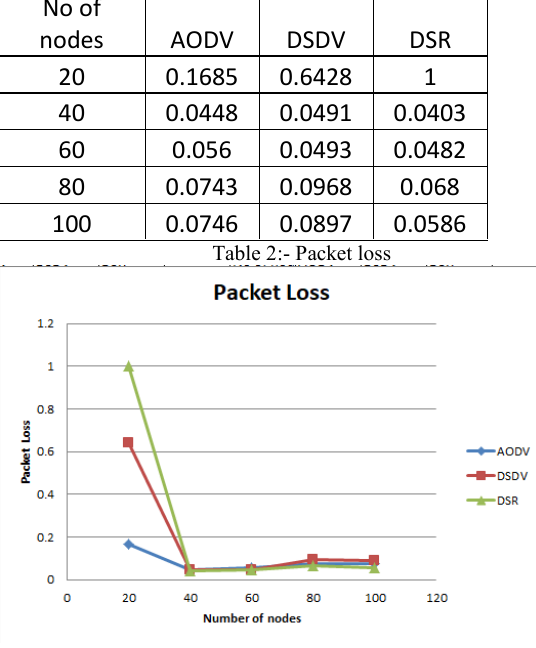
Figure 1:- Packet loss